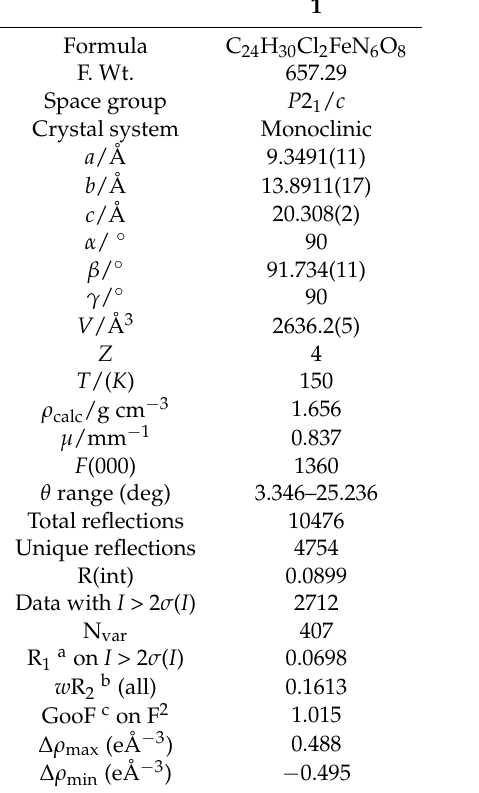
Table 1. Crystal data and structure refinement of compound [Fe(L6)](ClO 4 ) 2 ( 1 ).